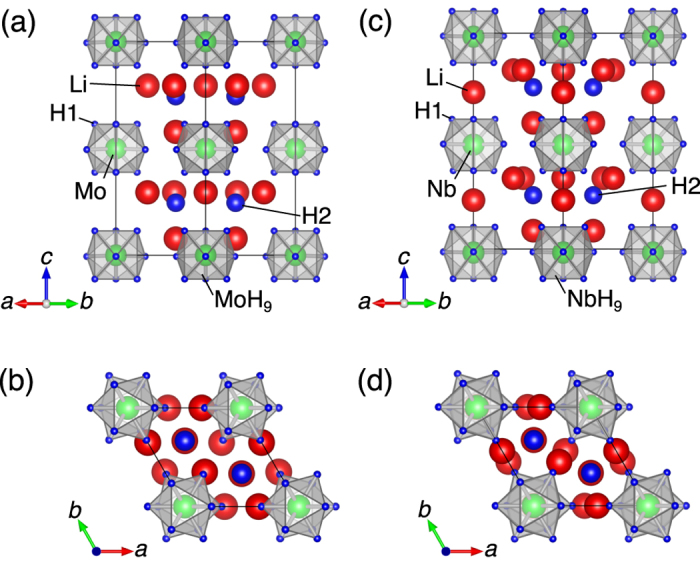
Crystal structures.(a–d) Density functional theory (DFT) structures of Li5MoH11 (a,b) and Li6NbH11 (c,d) viewed along the [110] (a,c) and [001] (b,d) directions. Li5WH11 and Li6TaH11 have isostructures to Li5MoH11 and Li6NbH11, respectively.